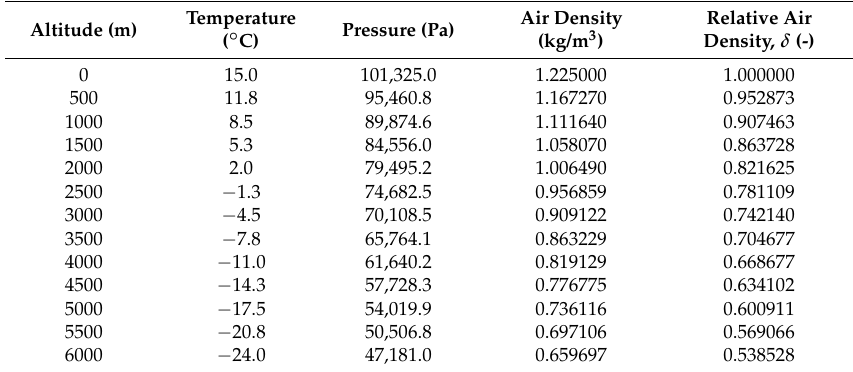
Table 2. The standard atmosphere